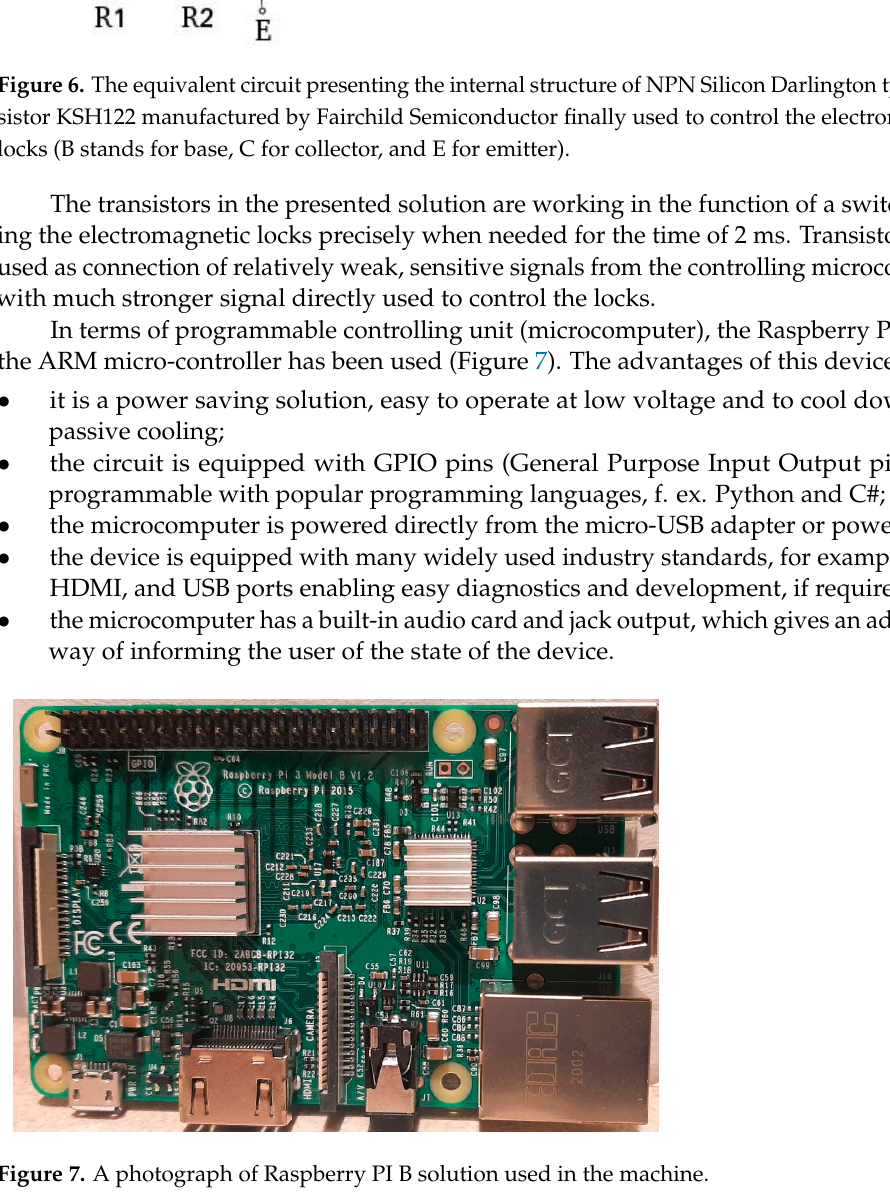
Figure 8. The fragment of the code in Python programming language. The pseudocode of the entire Algorithms 1 is presented below: Algorithms 1 . The pseudocode of the entire Algorithms 1 WAIT FOR INPUT (GENERAL STATE OF THE MACHINE); 2